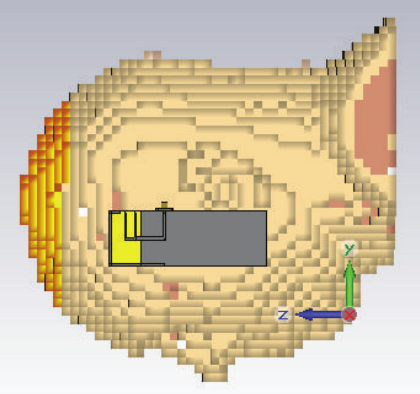
Figure 10: Antenna structure with the human head model (Hugo voxel